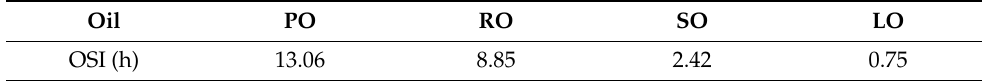
Table 1. OSI of four kinds of vegetable